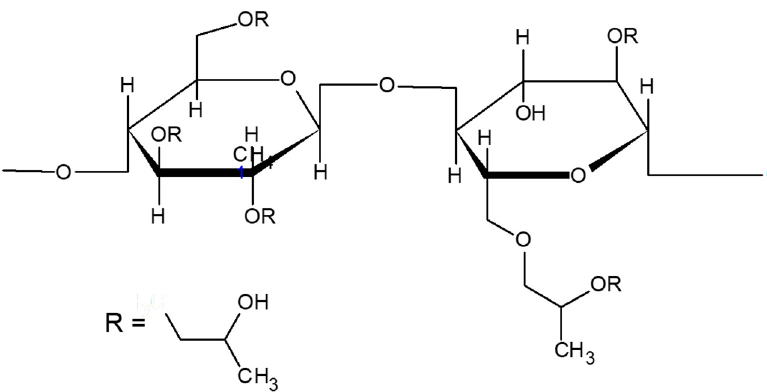
Figure 1. An idealized structure of hydroxypropyl cellulose with a molar substitution of